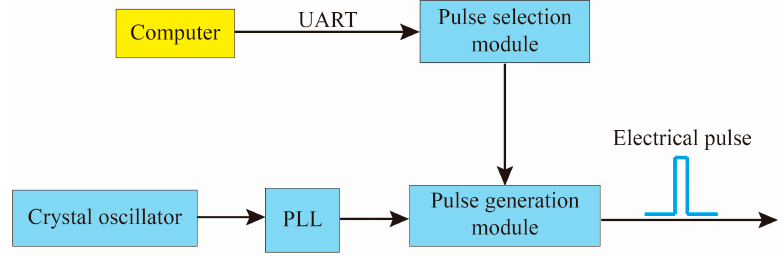
Figure 3. Structure diagram of pulse signal source based on phase-locked loop (PLL).